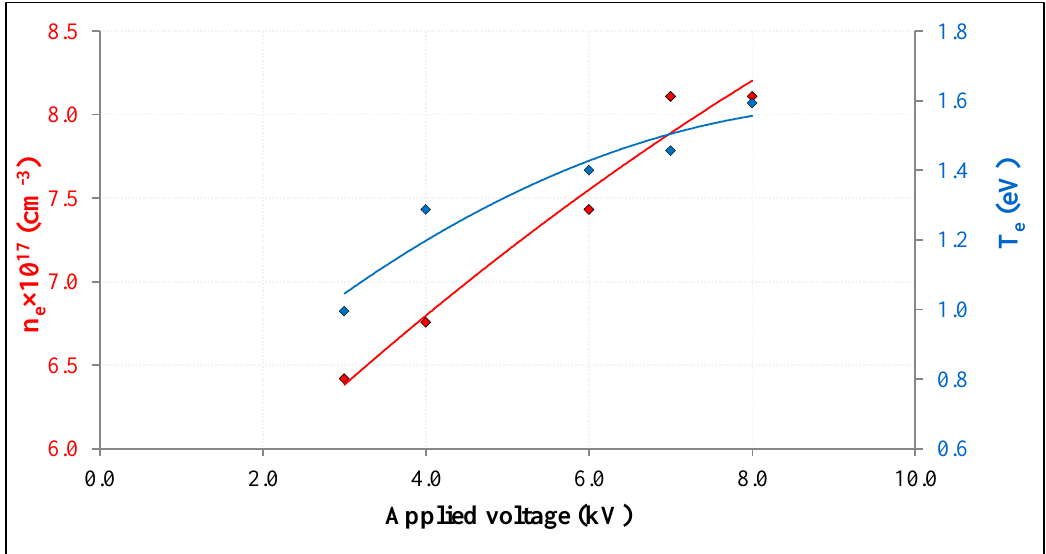
Figure 4: Boltzmann plots for produced plasma dielectric barrier